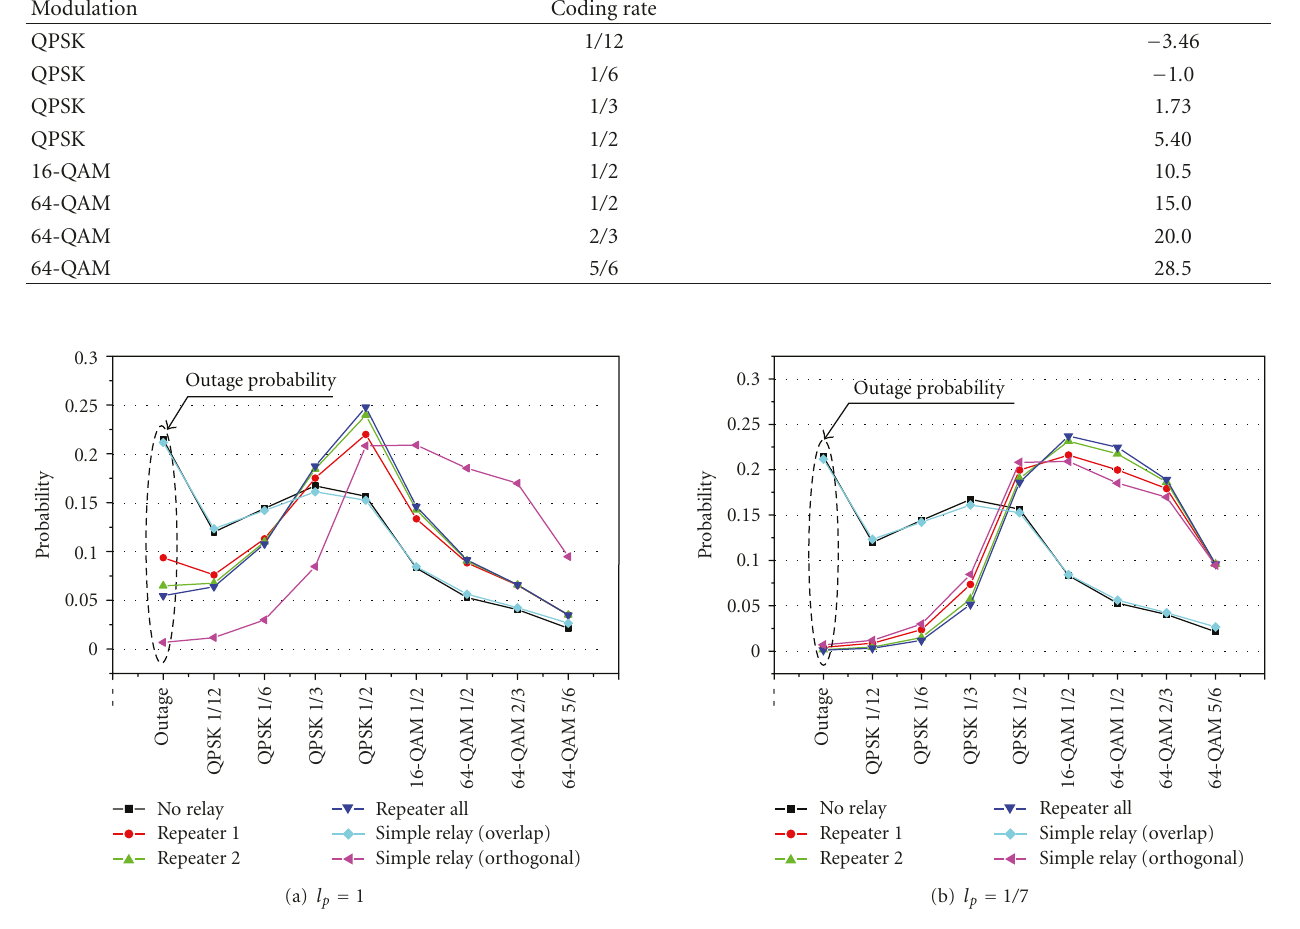
Figure 8: Distribution of the MCS level and service outage rate.